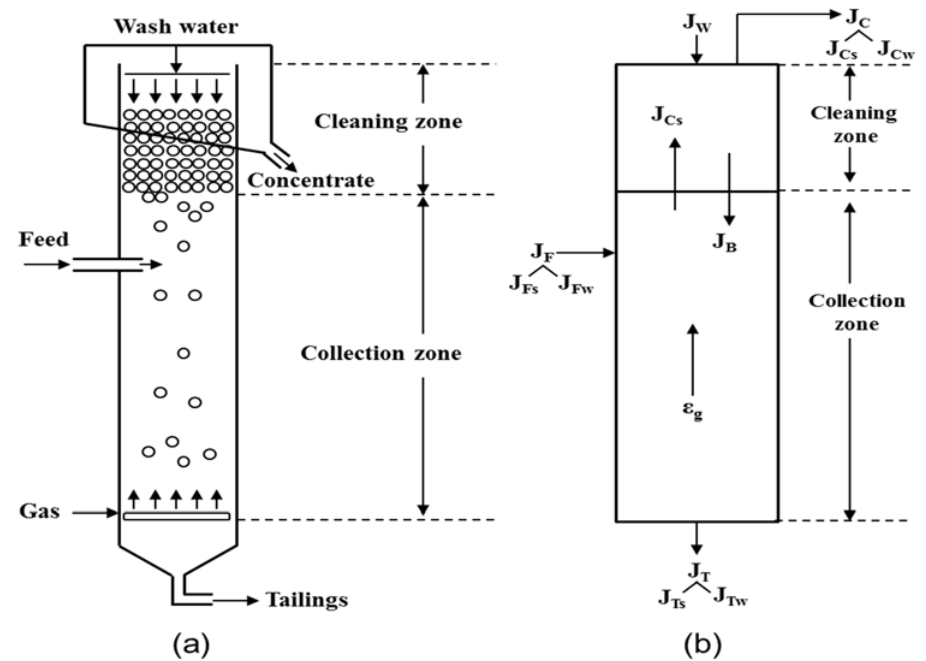
Figure 1. ( a ) Schematic diagram of flotation column and ( b ) superficial velocities in column.